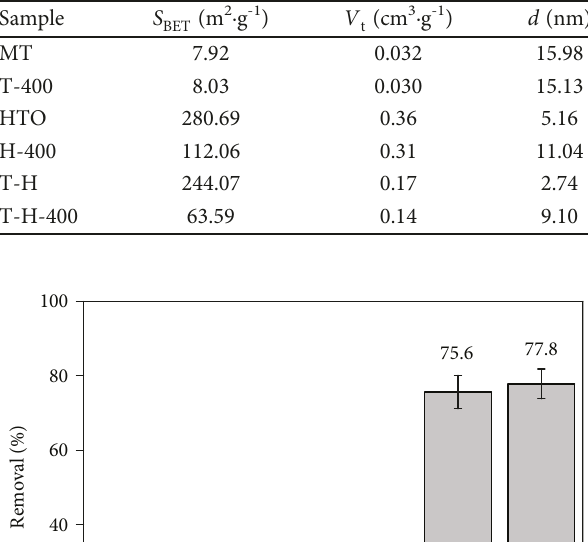
Figure 9: Full-scan UV – Vis absorption spectrums of 2,4-DCP solution after treatments by all samples. Initial 2,4-DCP concentration: 50mgL -1